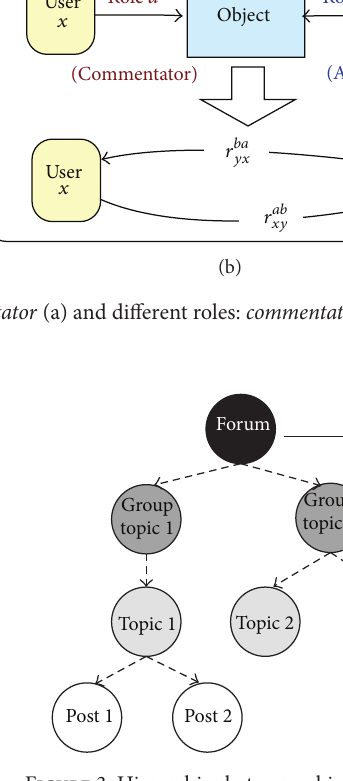
Figure 3: Hierarchies between objects in the Internet